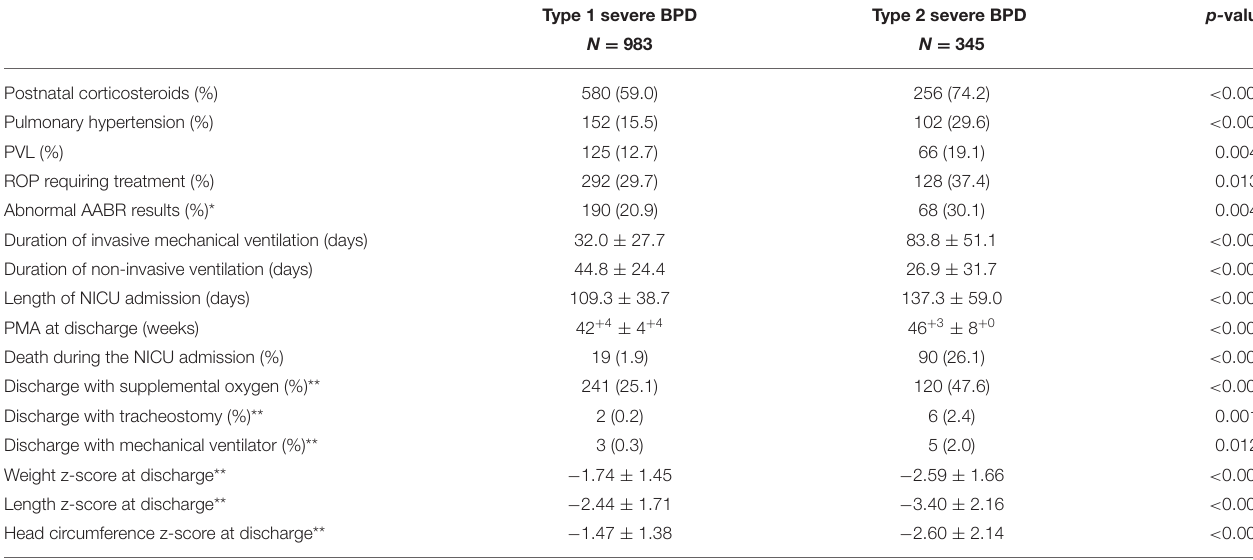
TABLE 2 | Comparisons of comorbidities and clinical burden between the type 1 and type 2 severe BPD groups.